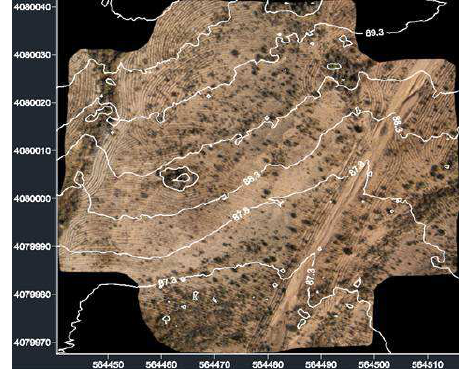
Figure 6. 1 cm orthophoto of the photogrammetric project with contour lines with an equidistance of 0.5 m